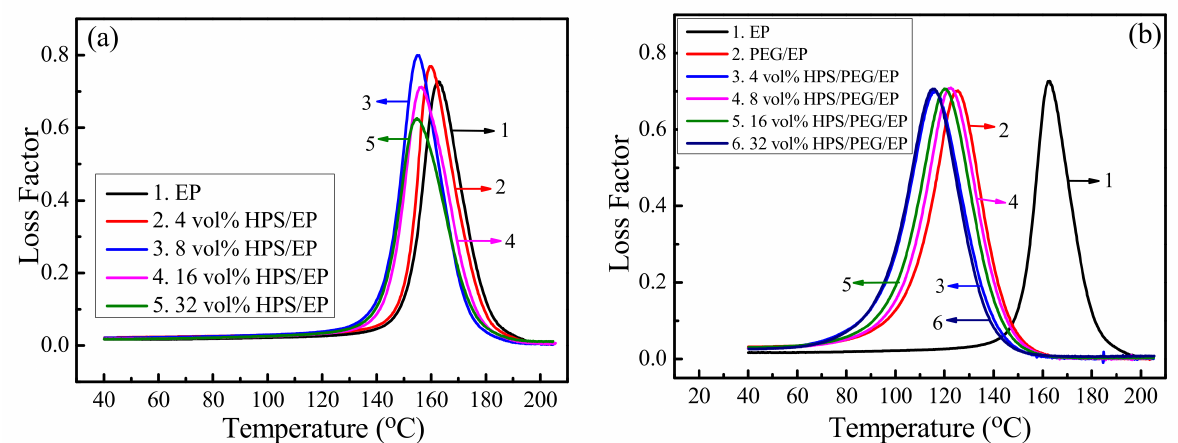
Figure 5. ( a ) The loss factors of the EP and HPS/EP composites; ( b ) the loss factors of the EP and HPS/PEG/EP